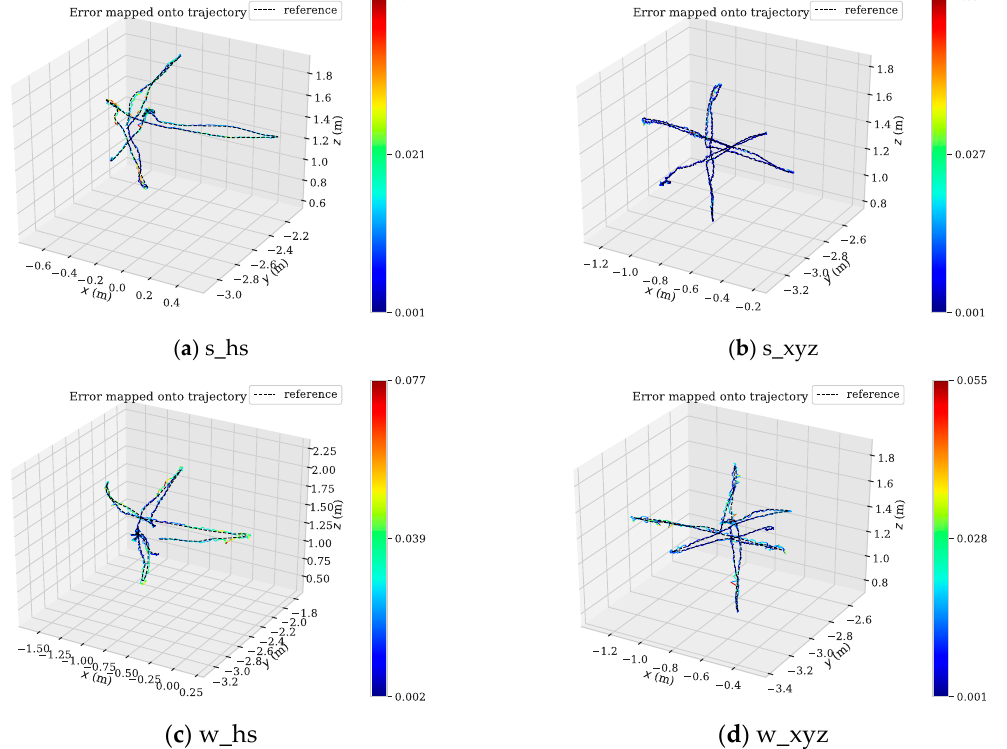
Figure 11. ( a – d ) The motion trajectory of DMS-SLAM in low dynamic (s_*) and high dynamic (w_*) datasets, where "reference" represents the Ground Truth. Where x and z represent the horizontal direction, and y represents the vertical horizontal direction.